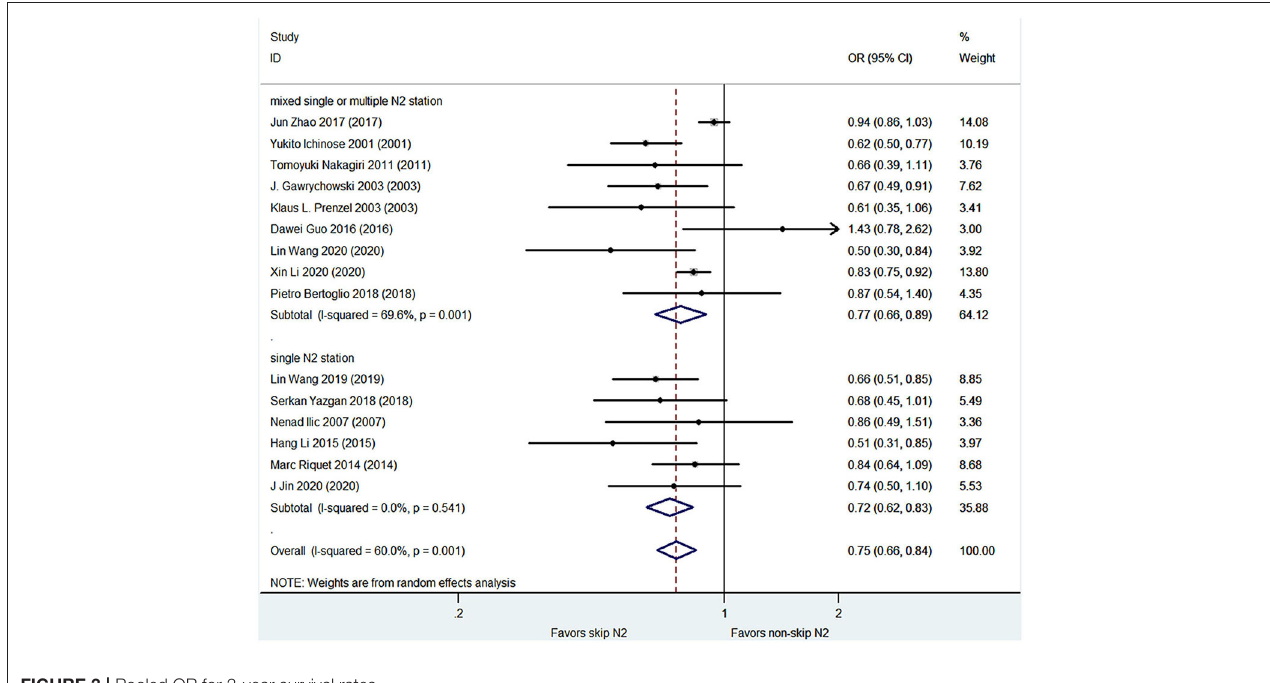
FIGURE 3 | Pooled OR for 3-year survival rates.